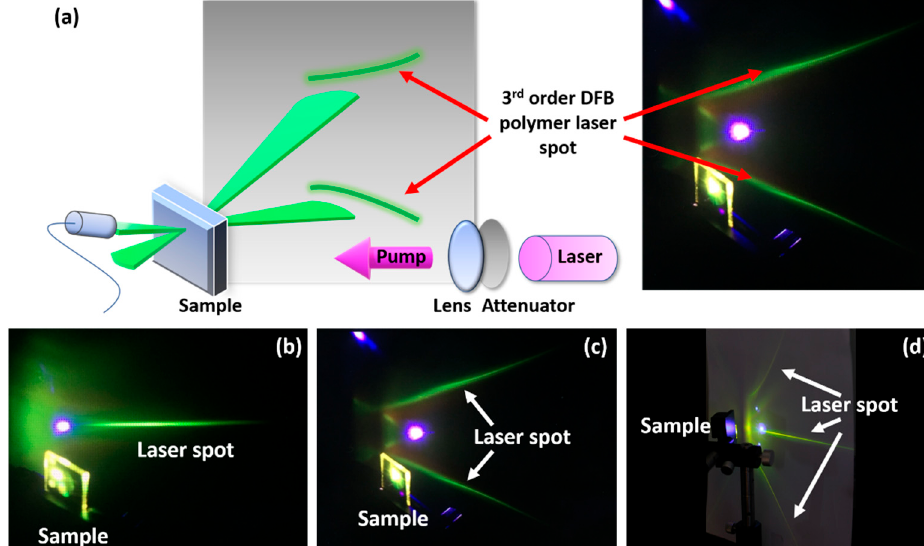
Figure 3. ( a ) Illustration of the experimental setup and formation mechanism of the pattern of a 3 rd order DFB polymer laser. The purple spots shown in the right photograph are the reflection and diffraction of the pumping laser. ( b ) 2 nd order laser pattern. ( c ) 3 rd order laser pattern. ( d ) 4 th order laser pattern.